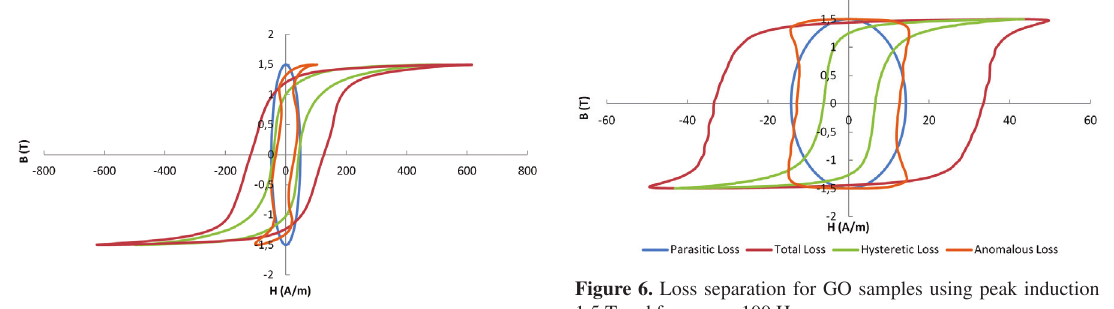
Figure 2. Loss separation for NO samples annealed for 2 hours at 600 °C with final grain size 11 µ m using peak induction 1.5 T and frequency 60 Hz.